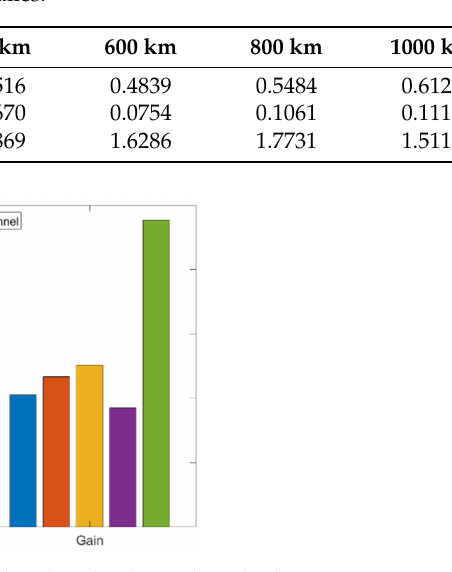
Figure 18. Comparison of single-channel method and multi-channel method.